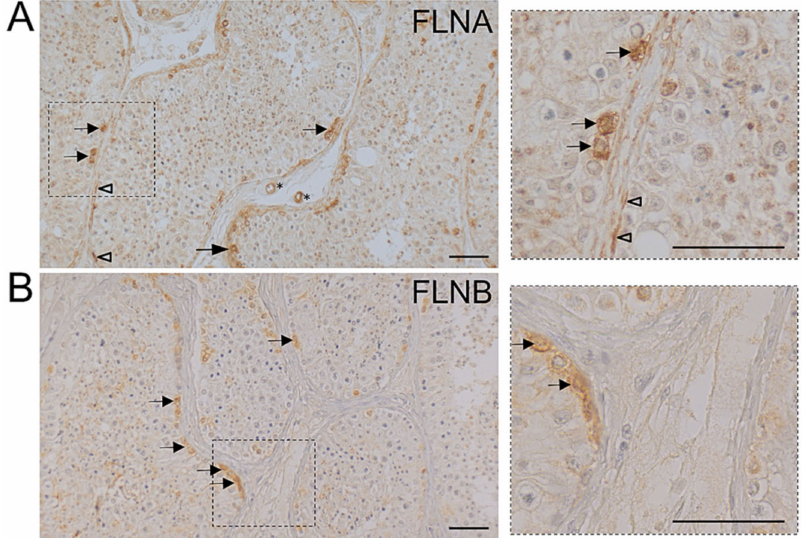
Figure 1. Immunohistochemistry of human testicular biopsies using isoform-specific antibodies directed against filamin A (FLNA) or filamin B (FLNB). ( A ) FLNA staining is found in peritubular, myoid cells (arrow heads in (A) and the enlargement of the boxed area on the right) building the wall of seminiferous tubules as well as in spermatogonia (arrows in (A) and the enlargement of the boxed area on the right). Some cells, presumably Leydig cells and / or macrophages scattered in the interstitial compartment, as well as endothelial cells of blood vessels (asterisks in ( A )), are also slightly immunopositive. ( B ) FLNB immunostaining is restricted to spermatogonial cells (arrows in ( B ) and in the enlargement of the boxed area on the right) while peritubular, myoid cells are devoid of staining by FLNB-specific antibodies. Nuclei are slightly stained with hematoxylin. Scale bars: 50 µ